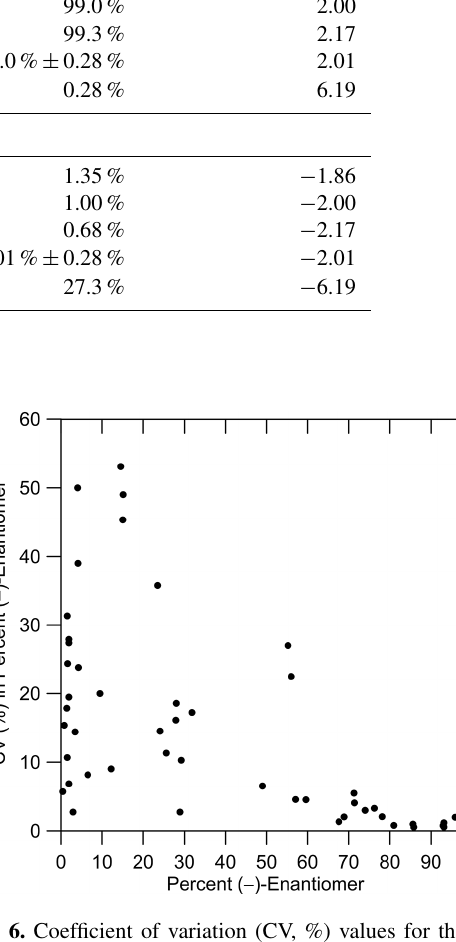
Figure 6. Coefficient of variation (CV, %) values for the percent ( − )-enantiomer vs. percent of the ( − )-enantiomer (based on data in Table 3a and b). CV < 20% for 75% of the data